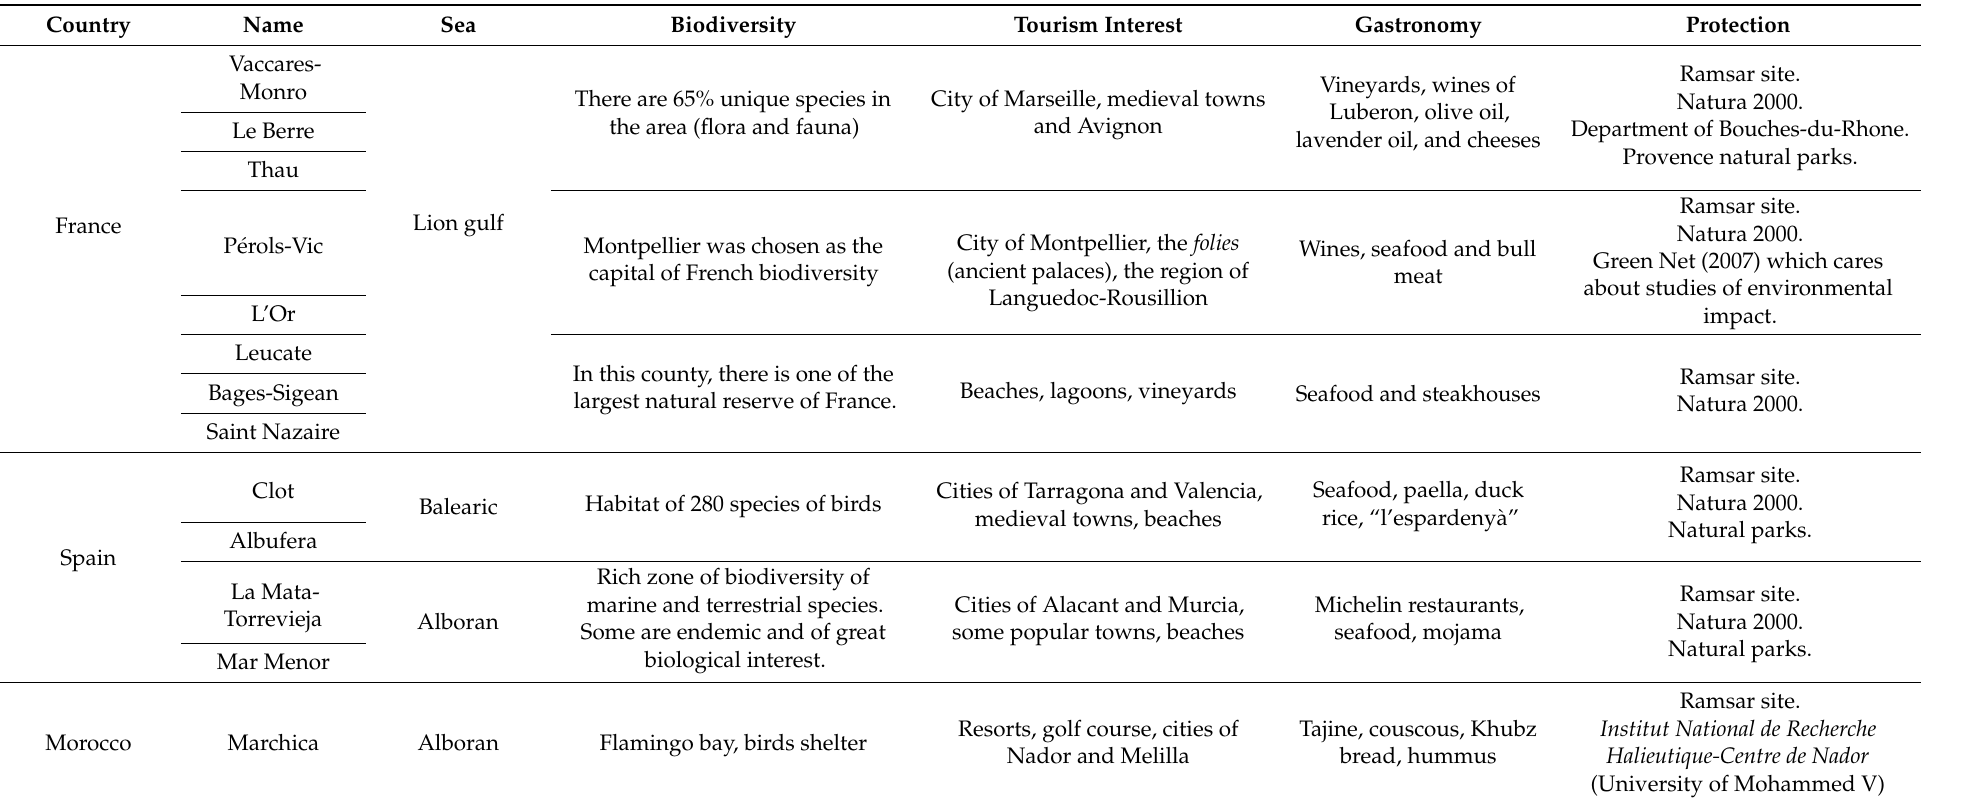
Table A2. Aspects of interest in the studied lagoons related to biodiversity, tourist interest, gastronomy and protection